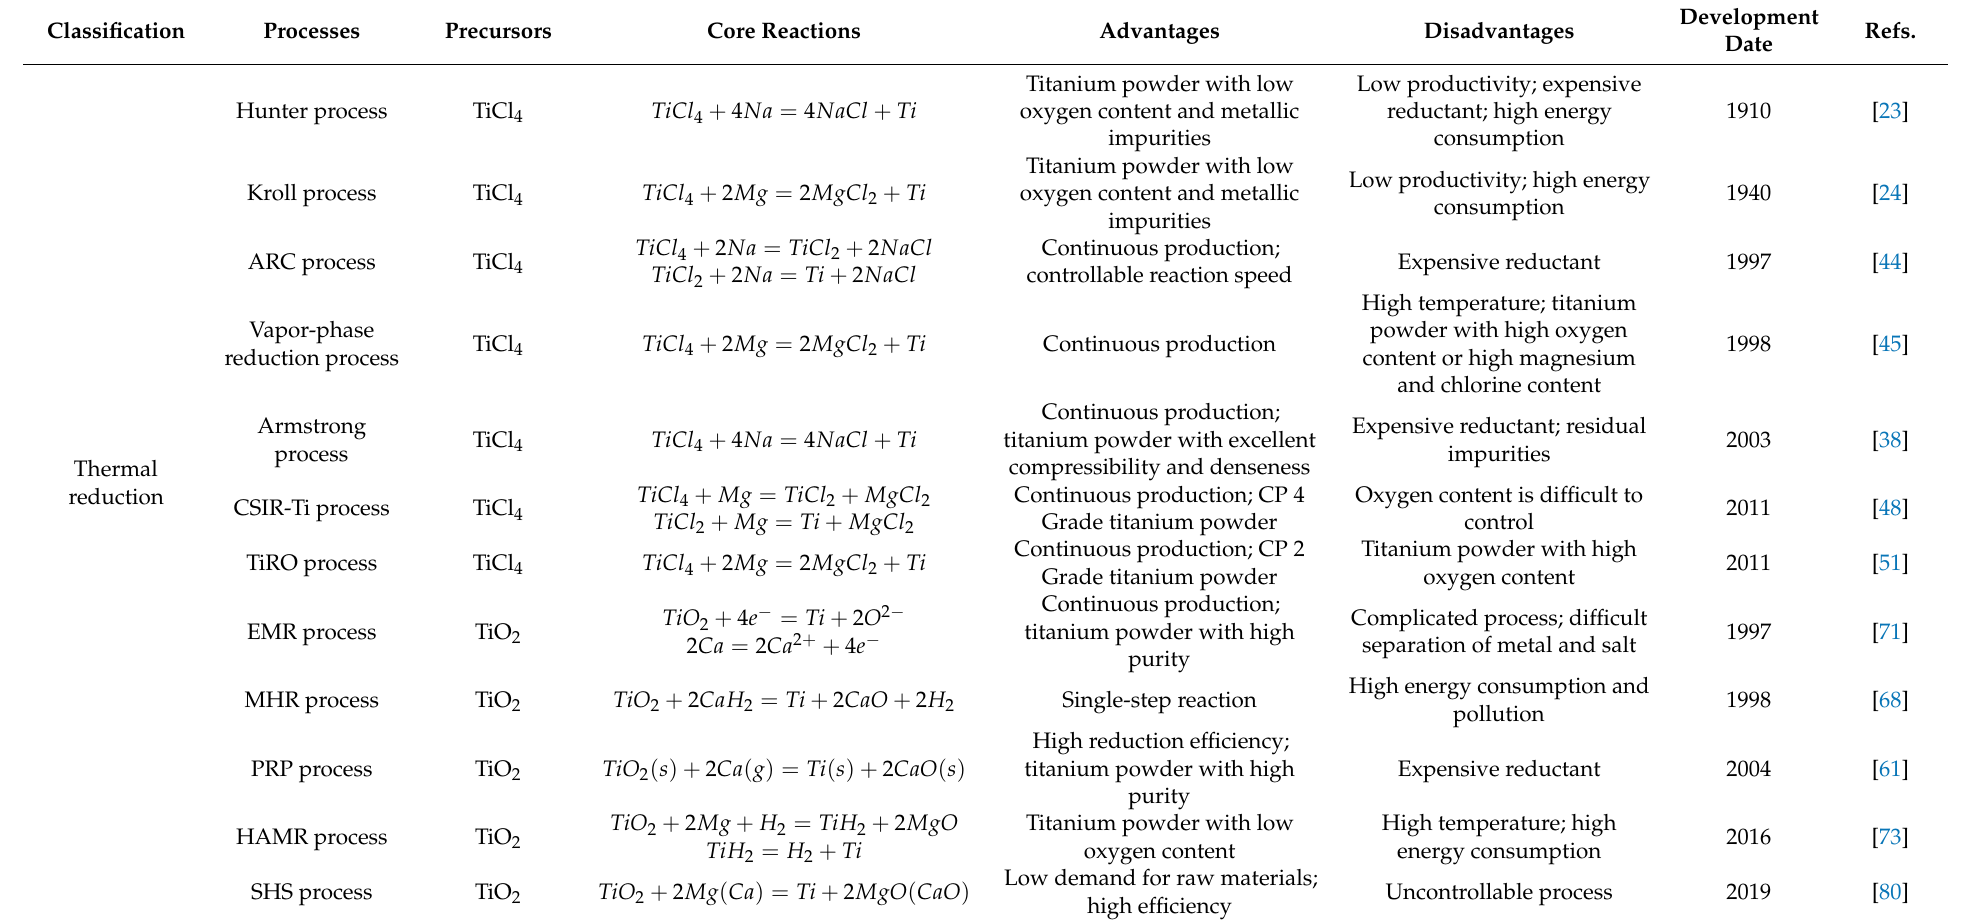
Table 1. Summary of titanium production